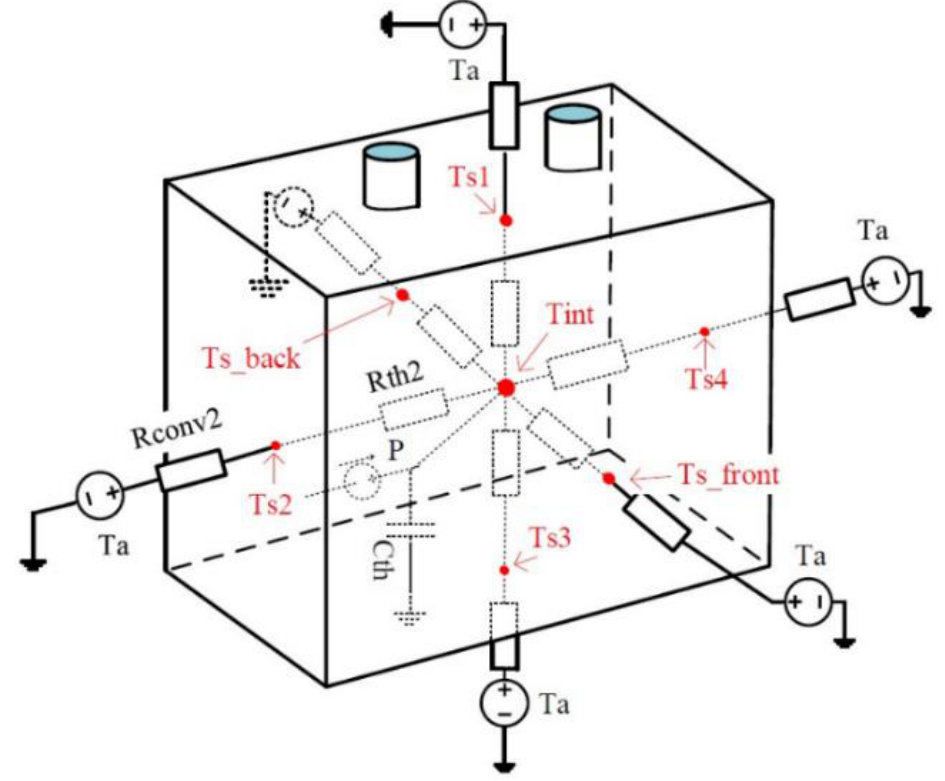
Figure 10. The RC branch used to predict the thermal behavior of LiC 3300 F cell that consists of four lateral sides (S 1 , S 2 , S 3 , and S 4 ) front and back sides [59,125].